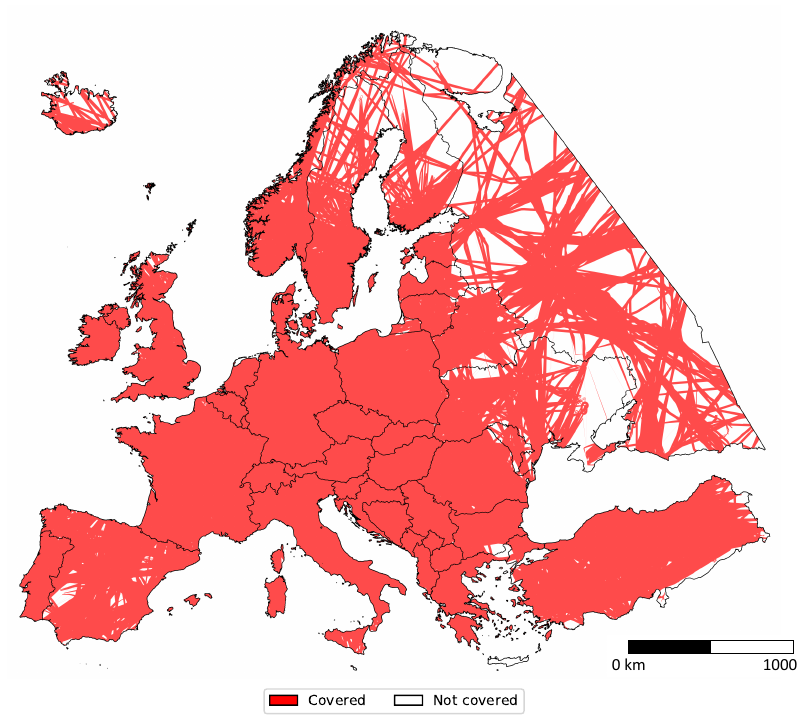
Figure 7. Land coverage of European countries/territories by all flights with Imperx